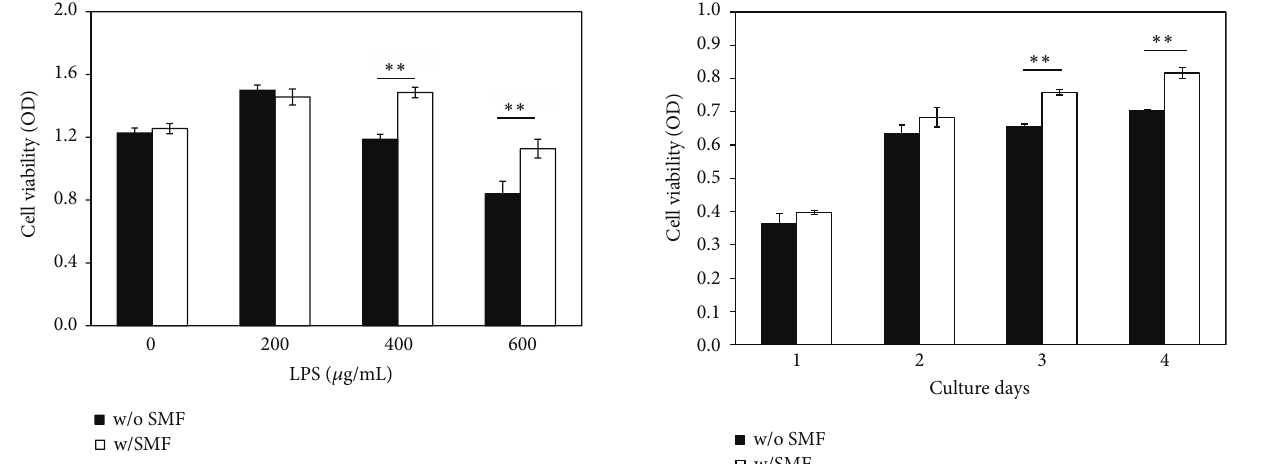
Figure 7: The effect of SMF on the LPS-induced cell viability changes to DPCs. Pretreatment with a 0.4 T SMF significantly attenuated the inflammatory response of